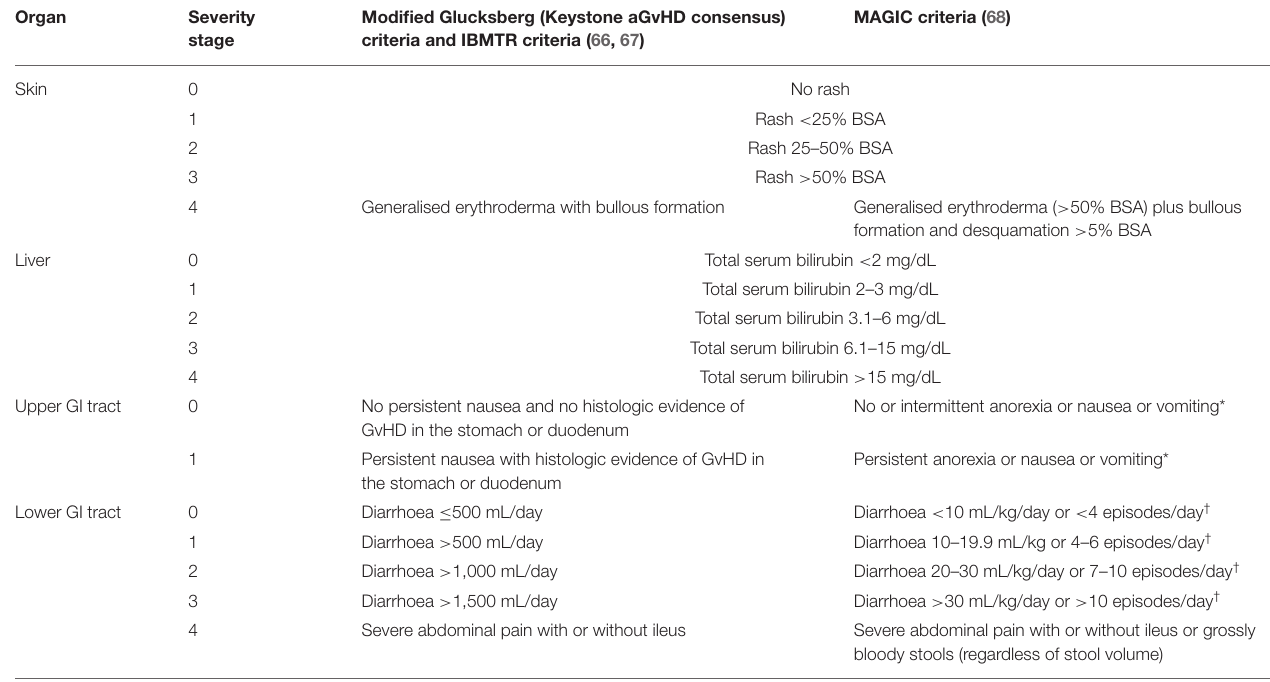
TABLE 1 | Assessment of Acute GvHD: staging of severity for individual organs according to the different classifications. Organ